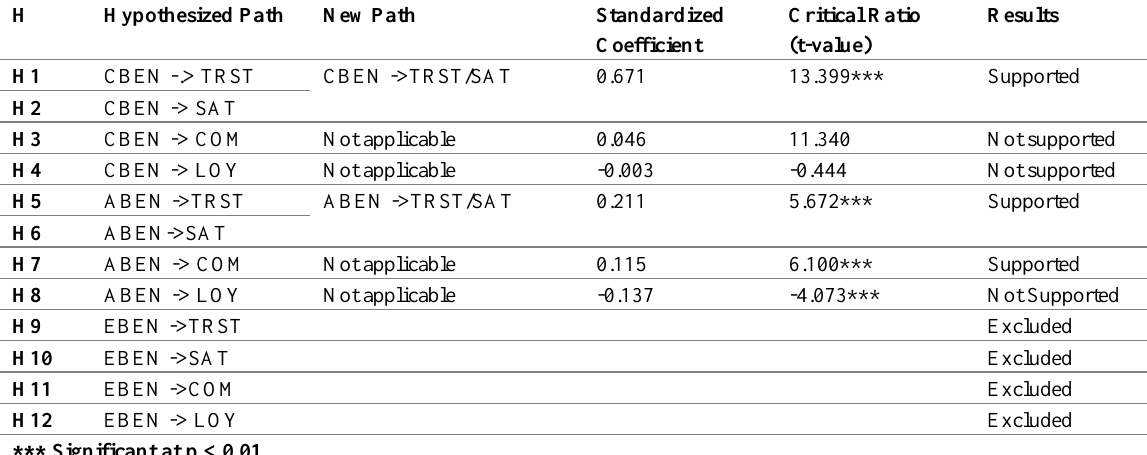
Table 4: Hypotheses Tests According to